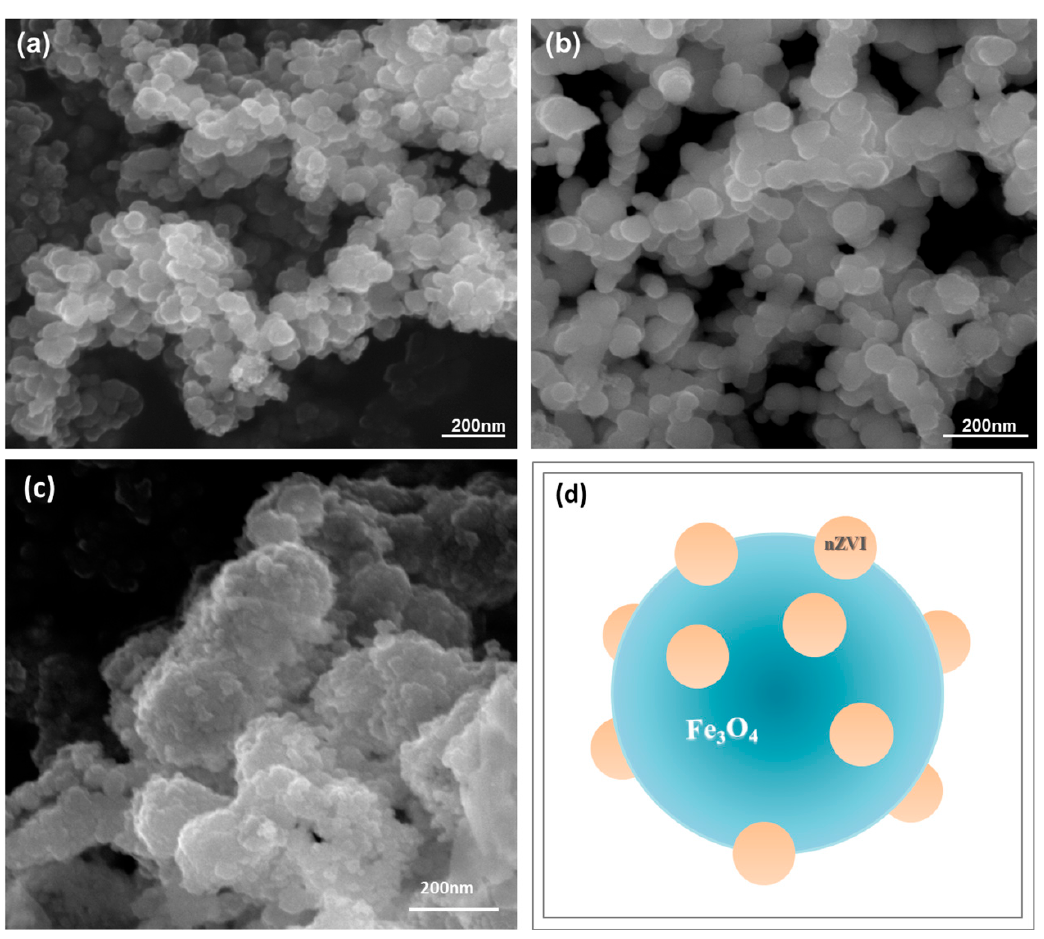
Figure 1. SEM images of ( a ) nano zero-valent iron (nZVI), ( b ) the original Fe 0 @Fe 3 O 4 NPs, and ( c ) the Fe 0 @Fe 3 O 4 NPs after reaction, and ( d ) the conceptual model of the Fe 0 @Fe 3 O 4 NPs.